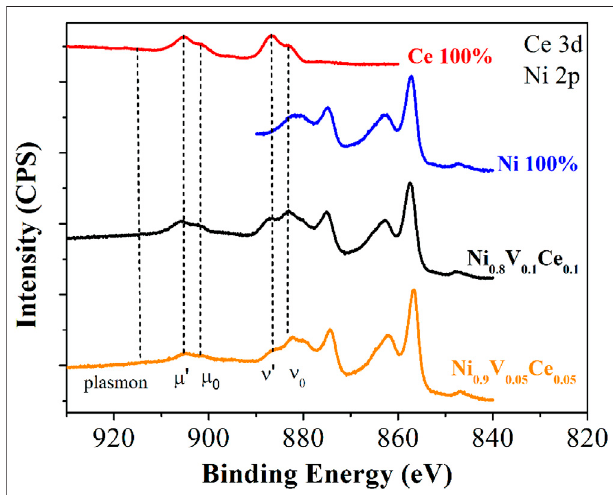
FIGURE 2 | High-resolution XPS from Ce 3d and Ni 2p core-levels involving trimetallic samples and pure element NPs for comparison (details in